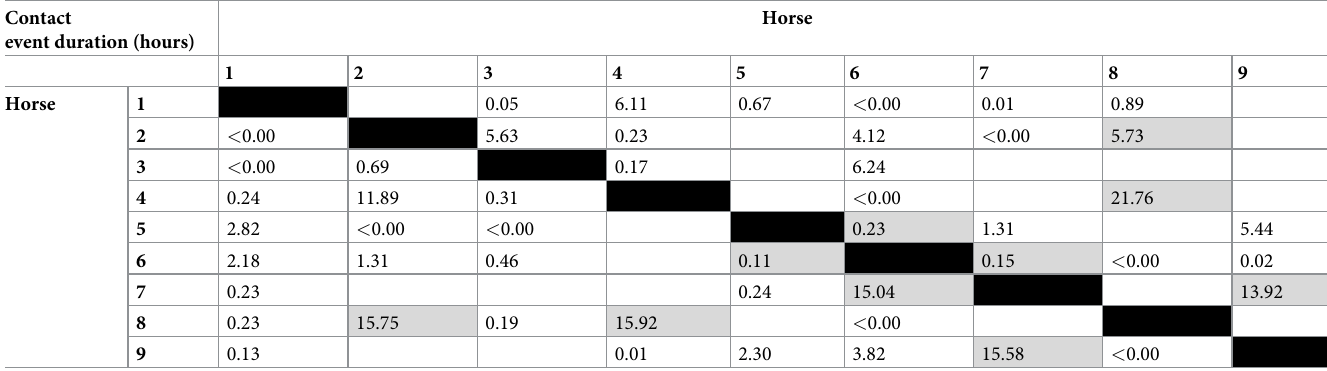
Table 2. Contact duration (hours) between horses on selected study days. The cells below the diagonal represent contacts that occurred on day 1 of the study, while the cells above the diagonal represent contacts that occurred on day 3 of the study. Highlighted cells indicate horses whose stalls were in the same area in the barn (Fig 1). All of the contact durations on the bottom half of the table represent the contacts that occurred on day 1 (Tuesday) of the study, while the contacts above the diagonal represent contacts that occurred on day 4 of the study (Thursday). The contact duration between the horses that were in the same area in the barn tended to be longer in than between the other